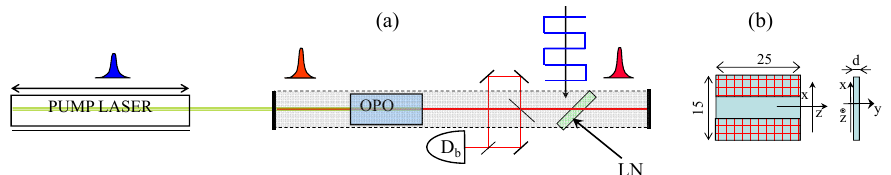
Figure 4. Two-pulse per cavity round-trip OPO. ( a ) sketch of the cavity configuration. The pump Figure 4: Two pulse/cavity round-trip OPO. (a) sketch of the cavity configuration. The pump cavity has half the cavity has half the length of the OPO cavity. D b : Beat note detector. LN: Lithium niobate modulator; length of the OPO cavity. D b : Beat note detector. LN Lithium niobate modulator. (b) Geometry of the d = 0 . 5 mm thickness lithium niobate phase modulator put at Brewster angle in the OPO cavity. ( b ) geometry of the d = 0.5 mm thickness lithium niobate phase modulator put at Brewster’s angle in the OPO cavity.